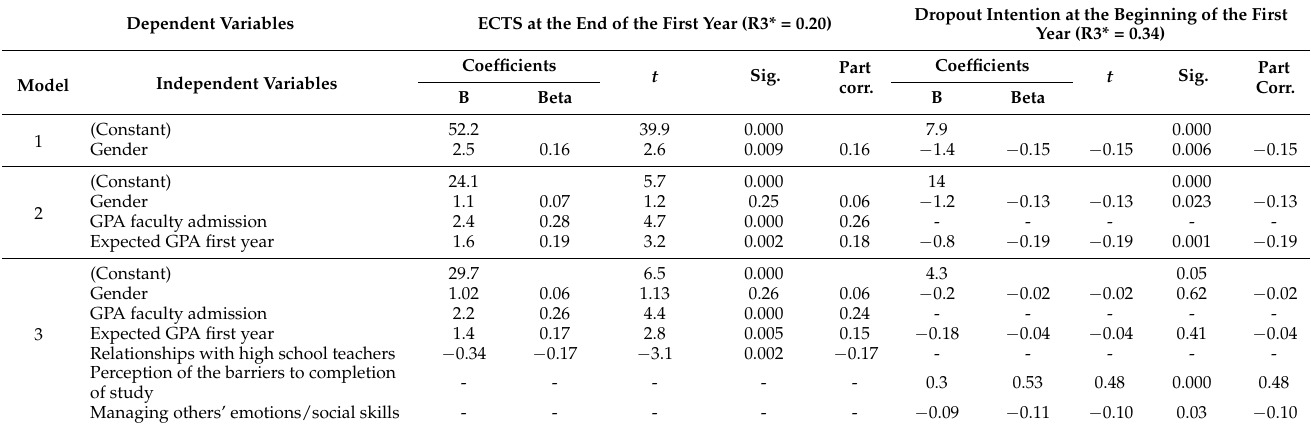
Table 5. Two hierarchical regressions in the first study (H1.4a and b).